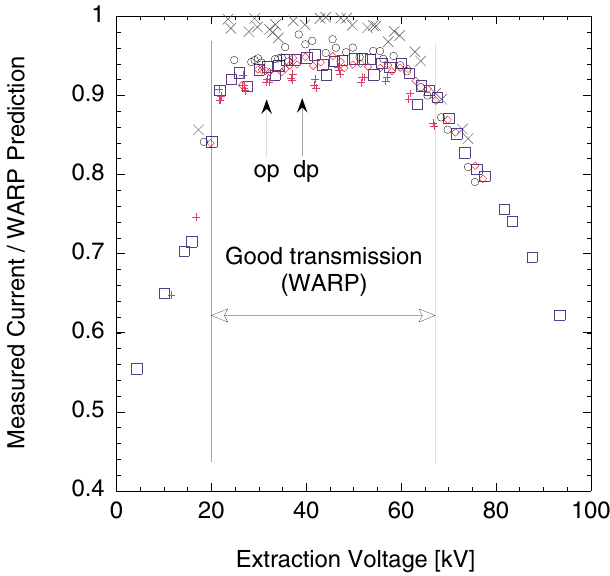
(cid:5) 940 kV ) for final Marx